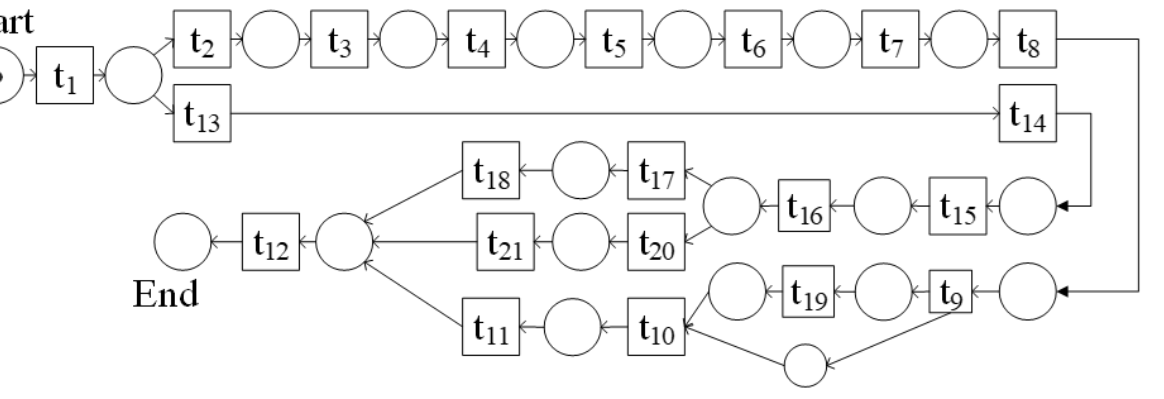
Figure 7. Example image of the predefined model part. Table 1. Correspondence table of event number and name.